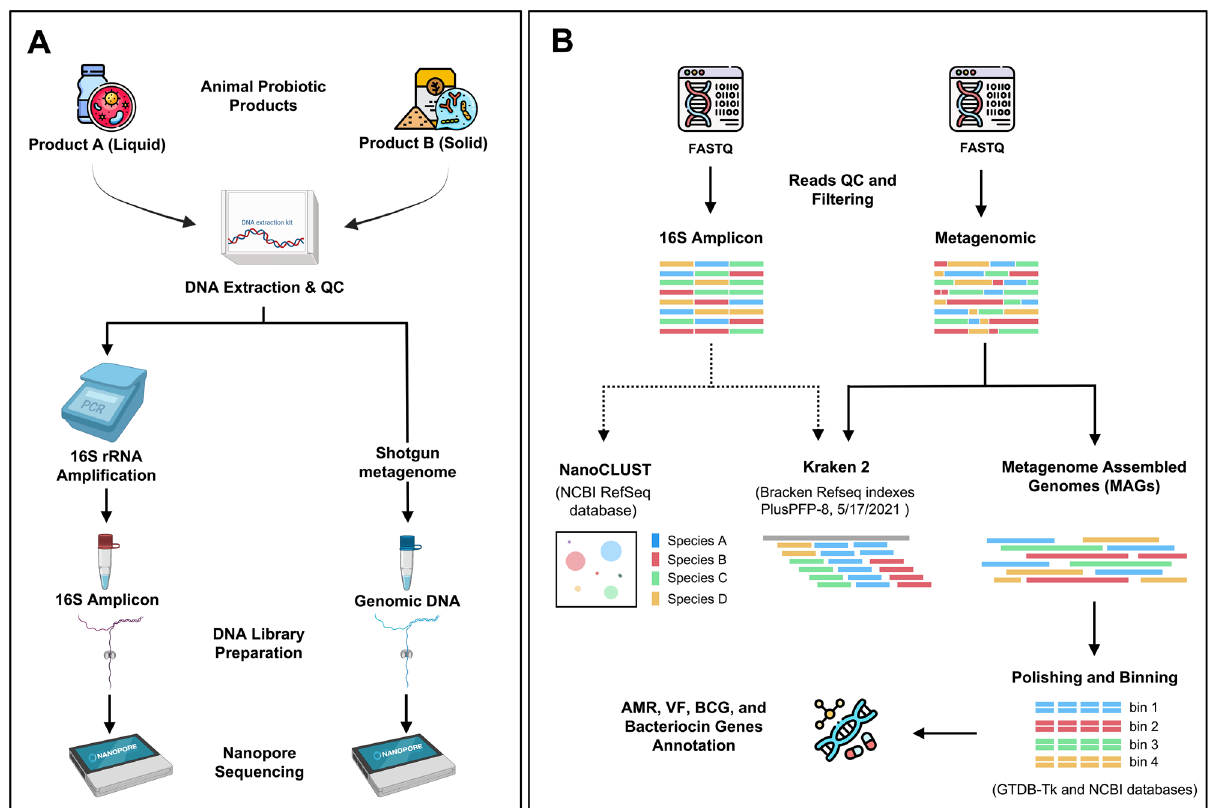
Figure 1. Schematic represents full-length 16S rRNA gene and metagenomic sequencing ( A ) and bioinformatic pipelines ( B ) for labelled strains investigation of animal probiotic products. Firstly, metagenomic DNA and 16S amplicon of animal probiotic products A and B were prepared and sequenced using Nanopore sequencer. Then, the nanopore reads were qualified and filtered by adapter trimming using porechop. After that, the 16S amplicon data were taxonomically identified by NanoCLUST and Kraken2 database while the metagenomic data were the taxonomically assigned using Kraken2 and assemble to the genome using the metagenome assembled-genomes (MAGs) approach. Genome taxonomy was determined using the GTDB-Tk database and only unidentified MAGs were identified by BLAST against the NCBI database. Finally, antimicrobial resistance (AMR) and function genes were predicted from metagenomic and MAGs data.